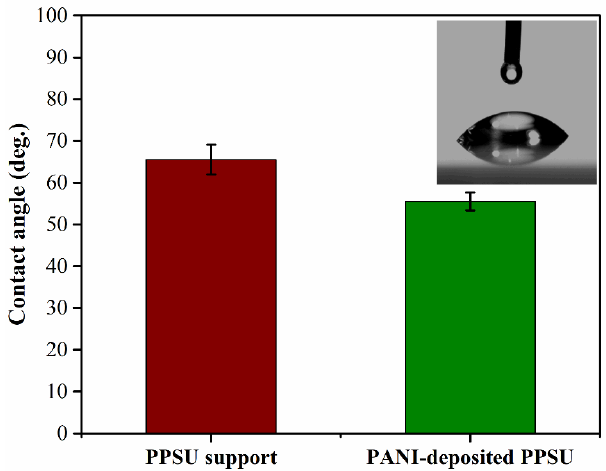
Figure 5. Water contact angles of the membranes.